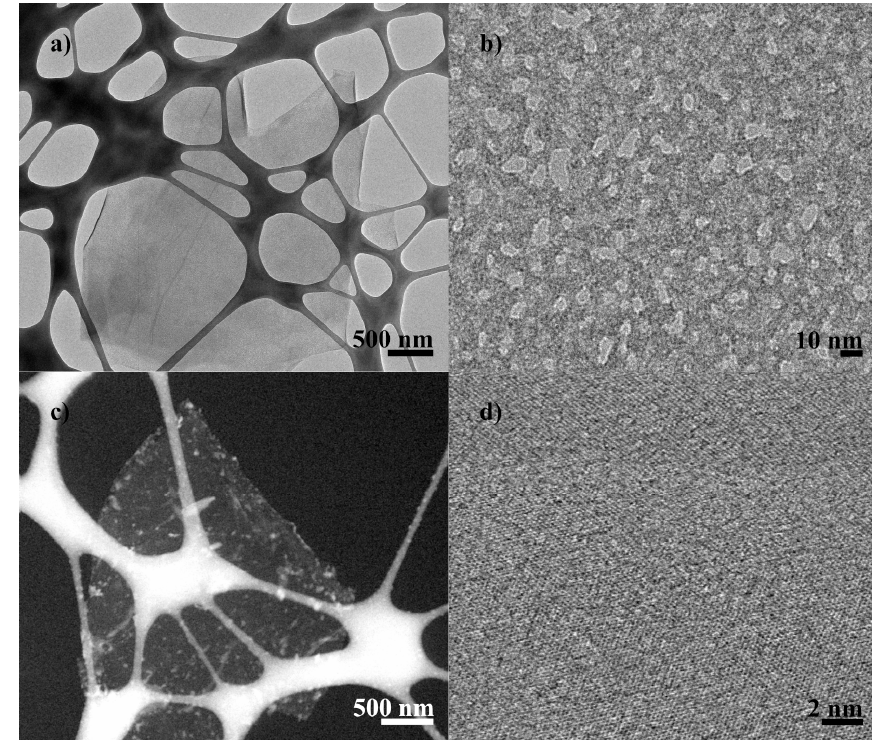
Figure 8. FETEM micrographs of high resolution mode STEM. ( a , b ) C2; ( c , d ) D2.